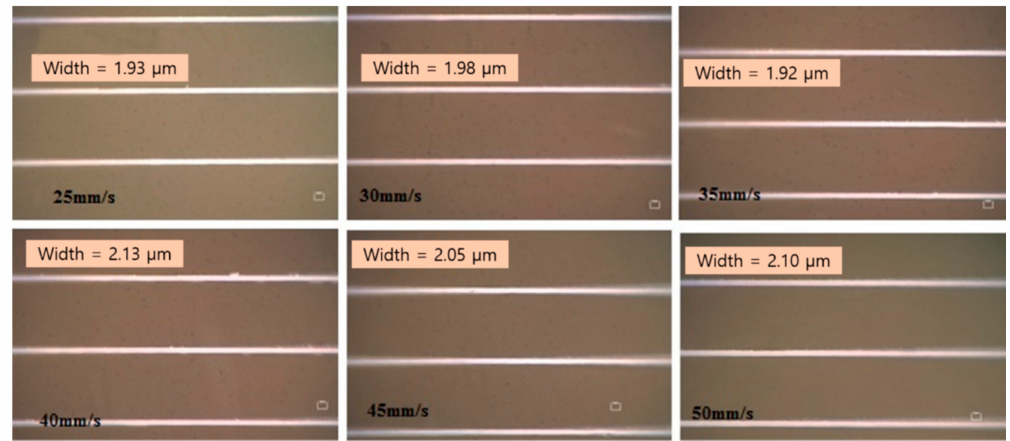
Figure 6. Results for the printed pattern with a 2- µ m line width in reverse offset printing using PUA5 resin as the clich é material with the highest surface energy (79.1 mN/m) at printing speeds ranging from 25 mm/s to 50 mm/s.